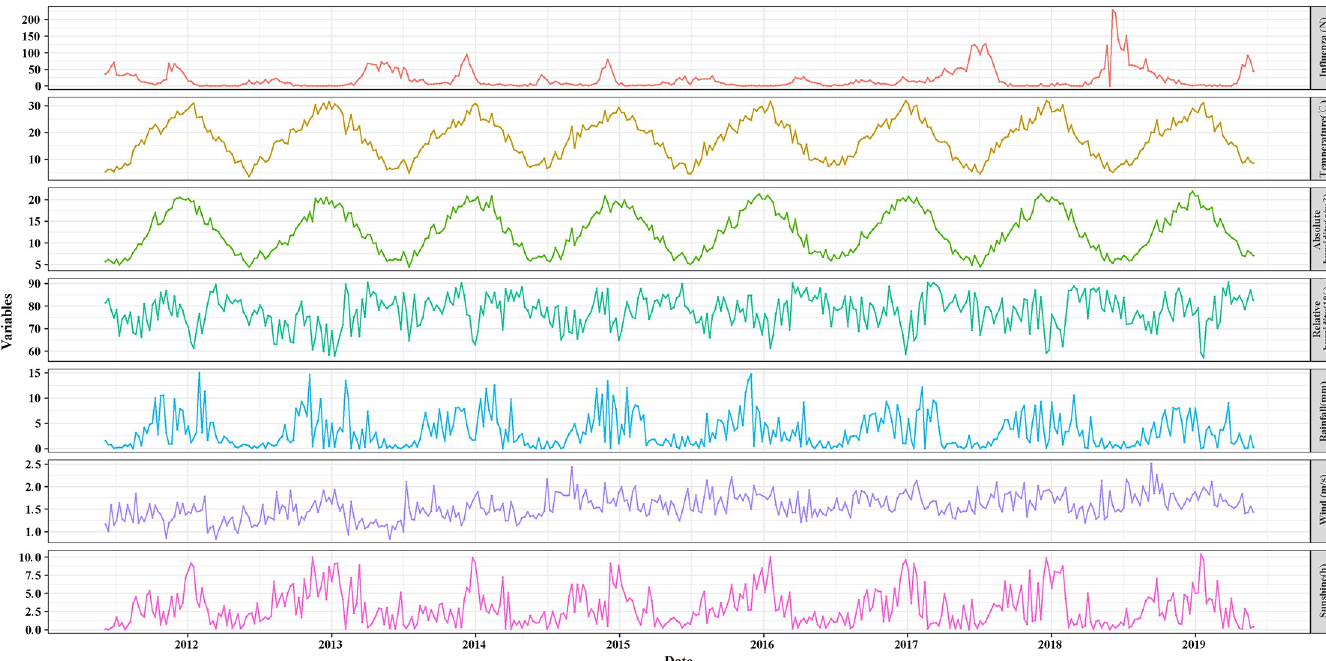
Fig 1. The distribution of weekly confirmed influenza cases every ten thousand outpatient visits and meteorological variables in Chongqing, China, 2012–2019.